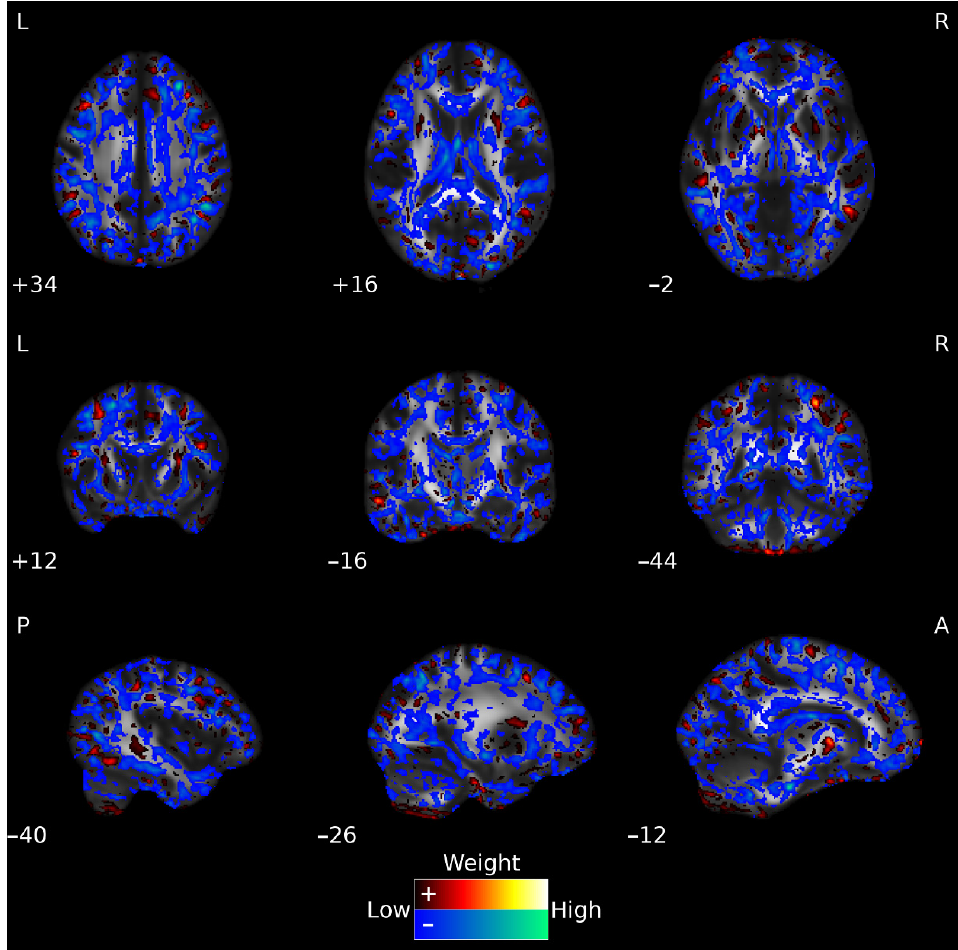
Figure 3. Voxels’ weights for the Early-HD vs. Pre-HD classification using whole-brain FA features. The hot (red-yellow) and cold (blue-green) color maps show the positive and negative weights, respectively. For visualization purposes, weight values at the lowest 10% range (closer to zero, positive, and negative) are not displayed. The ‘Low’ (closer to zero) and ‘High’ (further away from zero) descriptions refer to absolute weight values. The weight values are overlaid on a standard FSL target FA image, FMRIB58_FA. L: left; R: right; P: posterior; A: anterior. For each subcortical ROI, the weight maps corresponding to each classification model obtained using FA values are displayed in Figure 2 (bottom for FA), respectively.